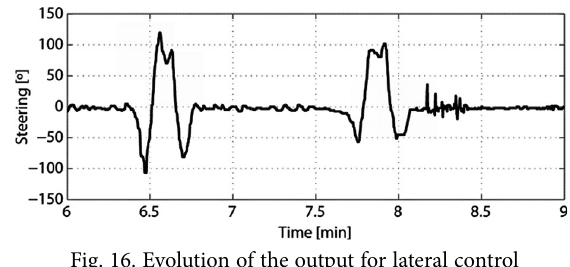
Fig. 16. Evolution of the output for lateral control